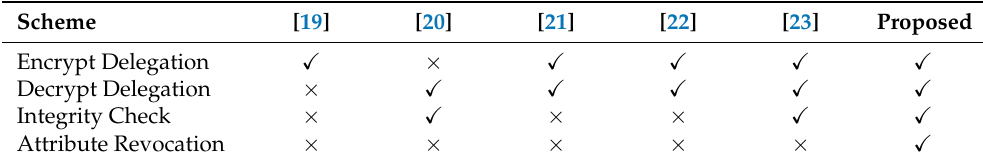
Table 2. Features